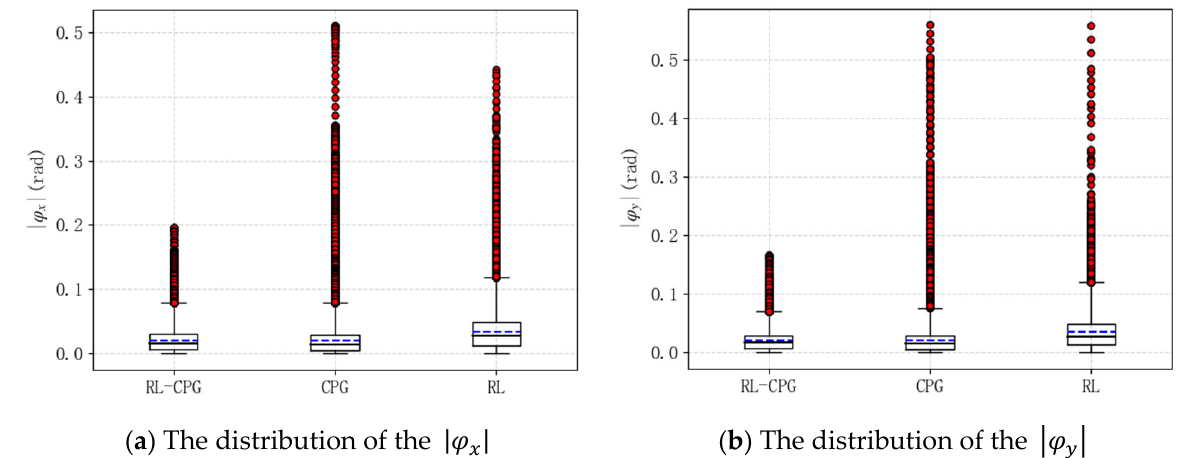
(cid:12) (cid:12) (cid:12) ϕ y (cid:12) between CPG and RL-CPG x | and